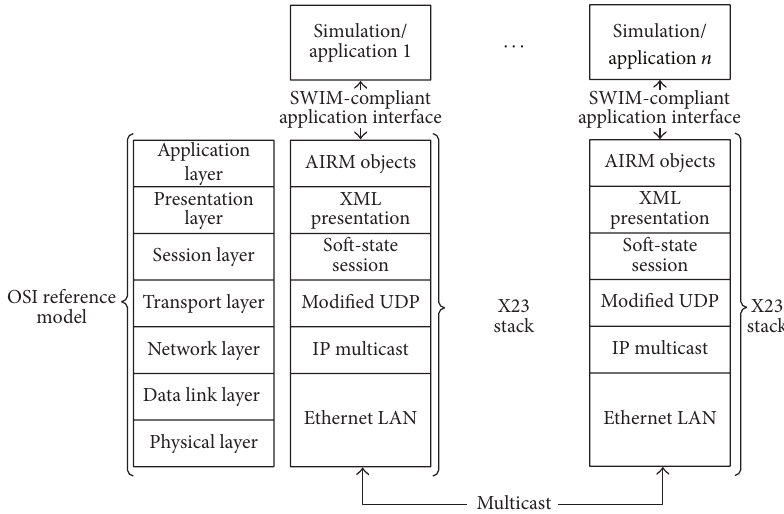
Figure 3: The X23 implementation covers the protocol stack from the application layer down to the network layer. The application layer implements the interface between the application and the X23 stack. The presentation layer covers the encoding of state changes in XML messages.Thesessionlayerestablisheslogicalsessionsrobustagainstcommunicationinterruptions.Thetransportlayerencapsulatesmessages in User Datagram Protocol (UDP) datagrams. The network layer and Ethernet take care of the actual multicast